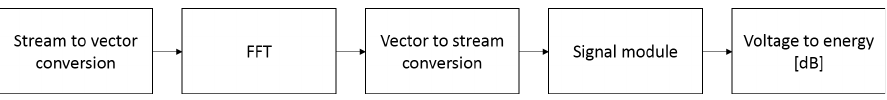
Figure 2. The GNU Radio sensing algorithm flowchart.